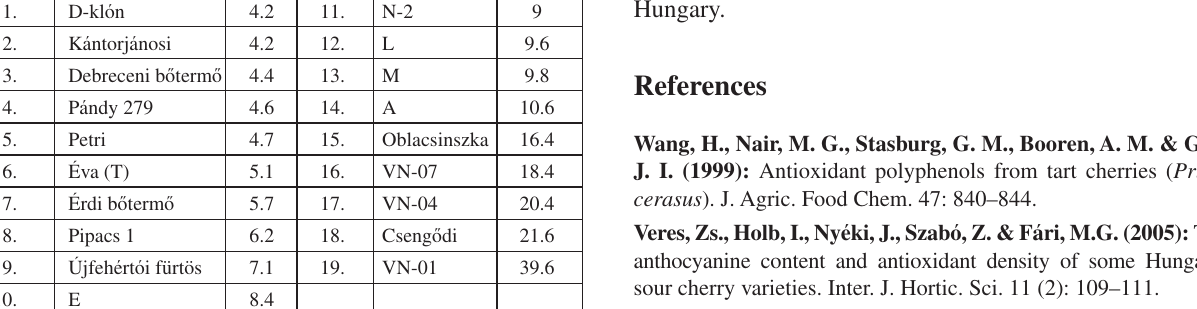
Table 3. Measurement of 19 experimental sour cherry varieties and clones by UVEX-ML-1 portable implement on diluted samples (Újfehértó, 2009) Num-